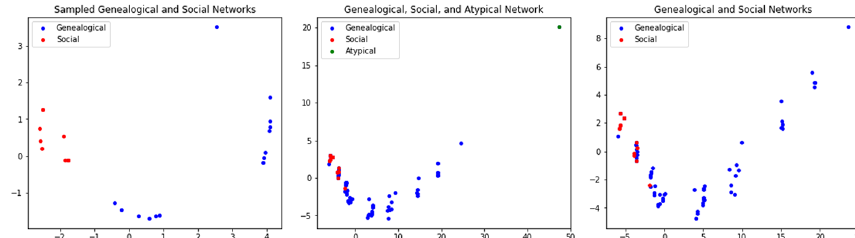
Fig. 8 PCA projections of the bottleneck distances between networks are shown. Left: The bottleneck distance between each of the twenty sampled genealogical and sampled social networks is shown. Center: The bottleneck distances are shown between the genealogical, social, and atypical genealogical networks we consider. Right: The bottleneck distances in the center panel are shown for only the genealogical and social networks we